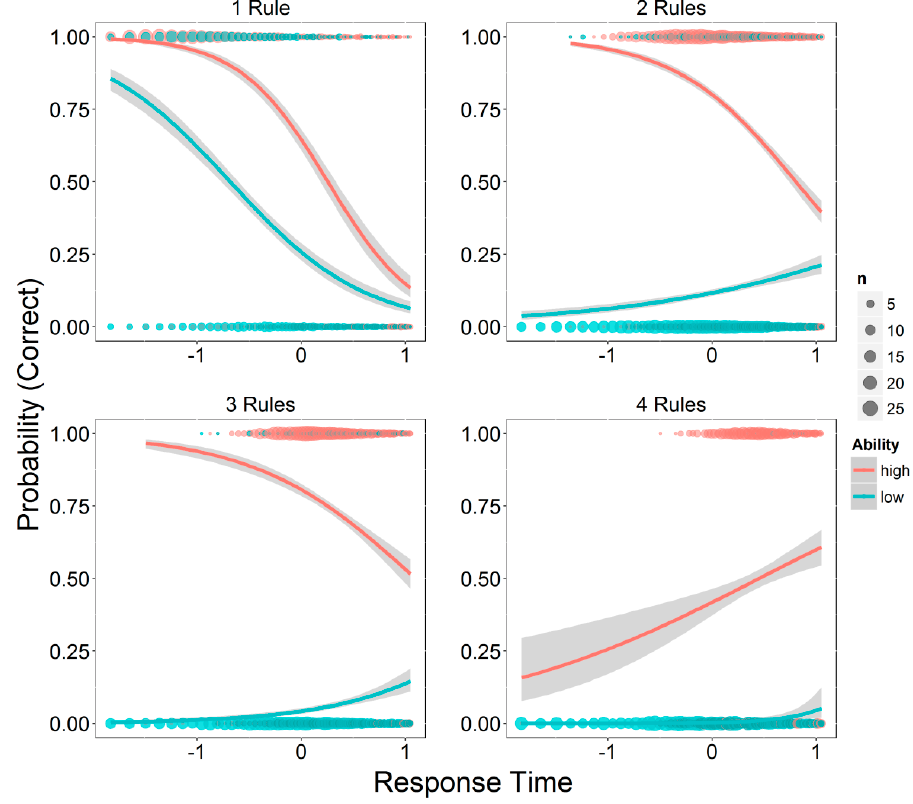
Figure 6. RTAC by number of rules and person ability.